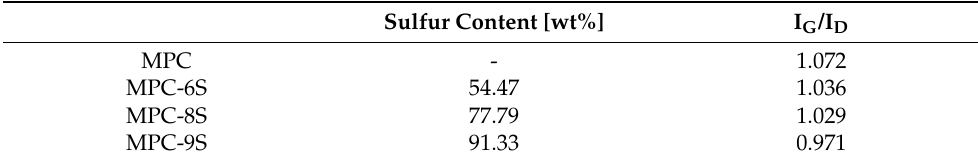
Table 1. Sulfur content and I G /I D ratio of the MPC, MPC-S composites. Sulfur Content [wt%]